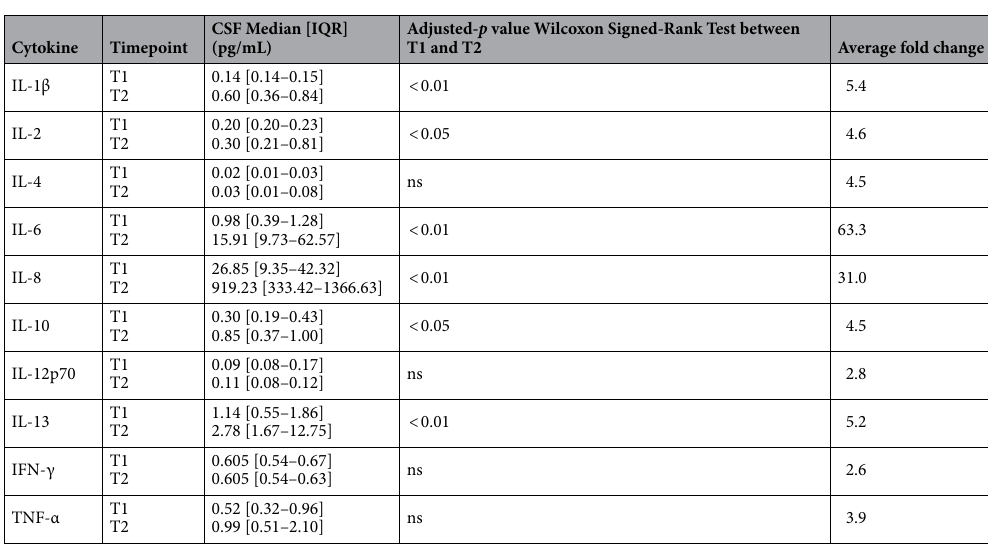
Table 2. Summary of cytokine measurements in CSF. Cytokine levels in cerebrospinal fluid (CSF) before surgery (T1) and the day after surgery (T2), ns =